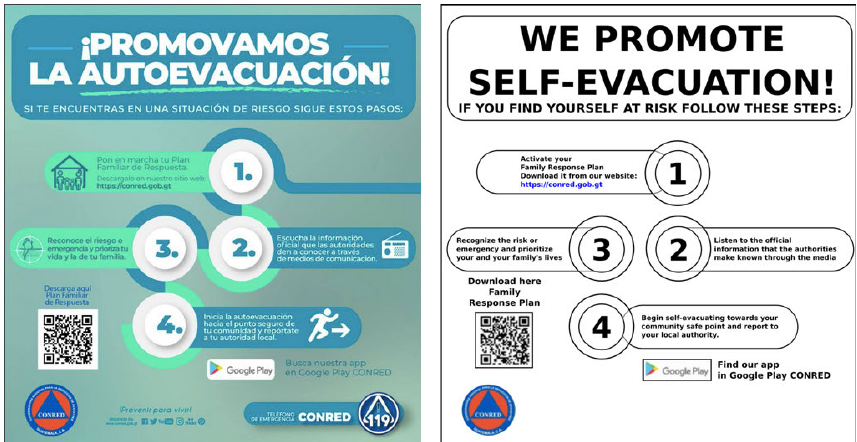
Figure 5: Infographic issued by CONRED promoting self-evacuation [left]; English translation [right]. their environments and make adjustments to